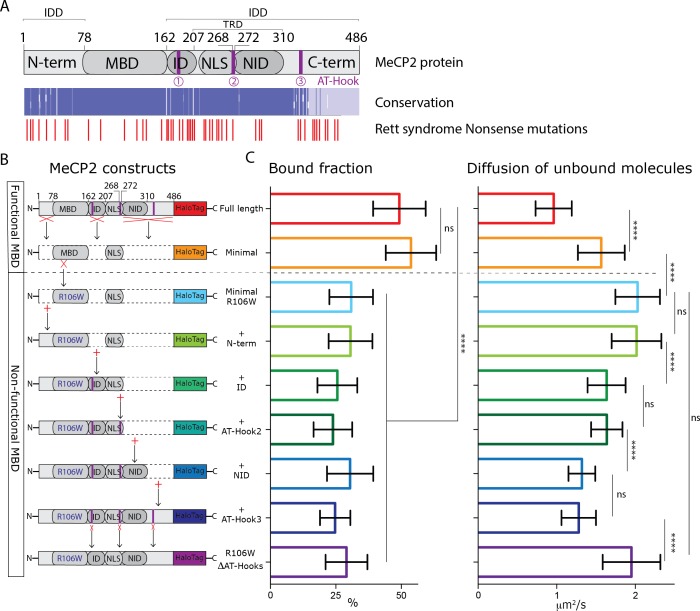
MeCP2 AT-Hook Domains hinder its nuclear diffusion without affecting its binding.(A) (Top) Schematic representation of full-length MeCP2 protein where known domains are annotated and the 3 AT-Hook domains are highlighted in purple. (Middle) Heat map representing protein sequence identity (from blue, high identity score, to white, no identity) between Human, Mouse, Rat and Dog MeCP2. (Bottom) Missense and nonsense Rett-syndrome causing mutation from RettBASE are annotated in red. (B) Diagrams of different DIO constructs used in the experiment, where MeCP2 was sequentially mutated. (C) Fraction of bound molecules and average diffusion coefficient of the unbound molecules calculated in individual cells by SpotOn for the different MeCP2 constructs. Full-length (red, 29 cells), Minimal (orange, 31 cells), Minimal R106W (cyan, 25 cells), +N-term (light green, 17 cells), +ID (green, 32 cells), + AT-Hook 2 (dark green, 27 cells), +NID (blue, 26 cells), +AT-Hook3 (dark blue, 11 cells), R106W-ΔAT-Hooks (purple, 32 cells). Graphs show mean and standard deviation of single cell values and compare the different constructs by two-tailed unpaired t-test: **** (p<0.0001).